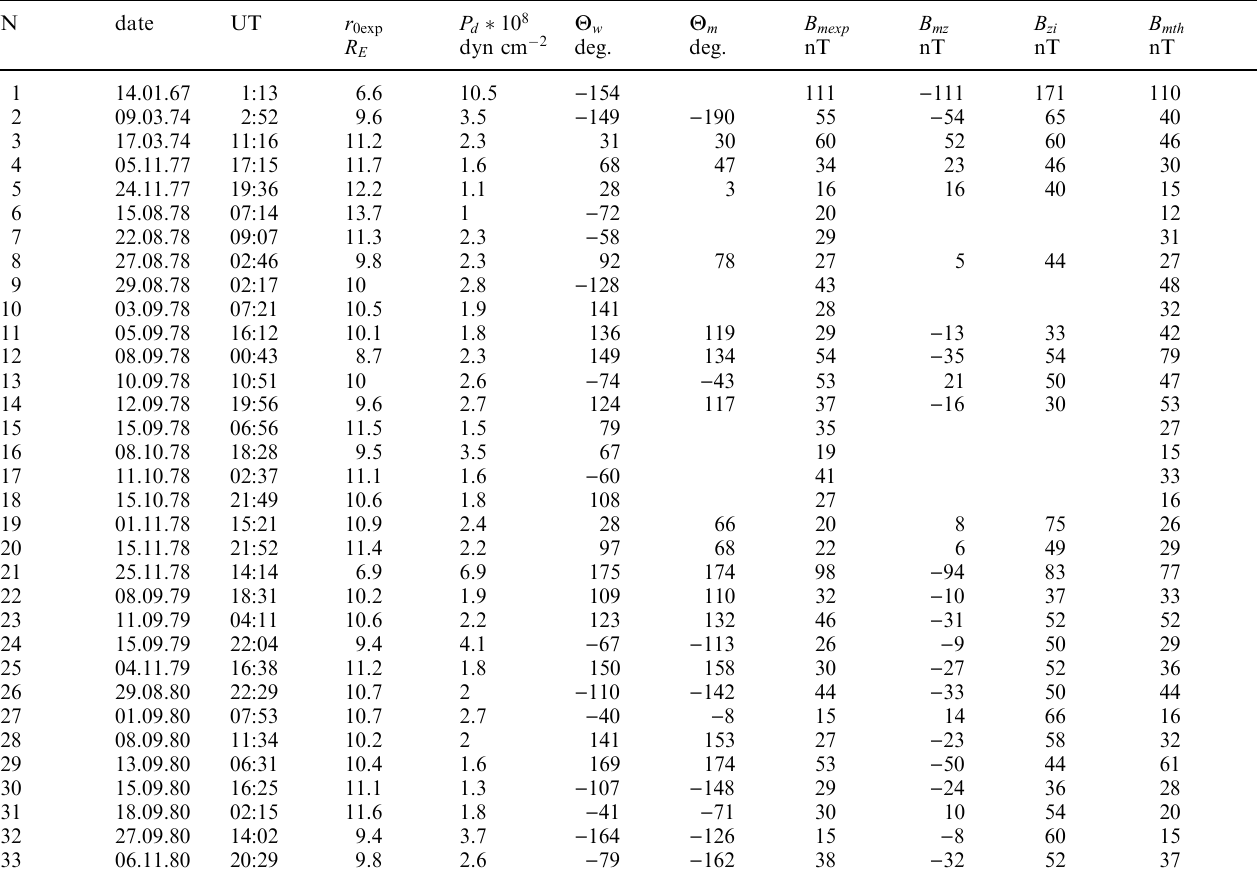
Table 1. List of magnetopause crossings N